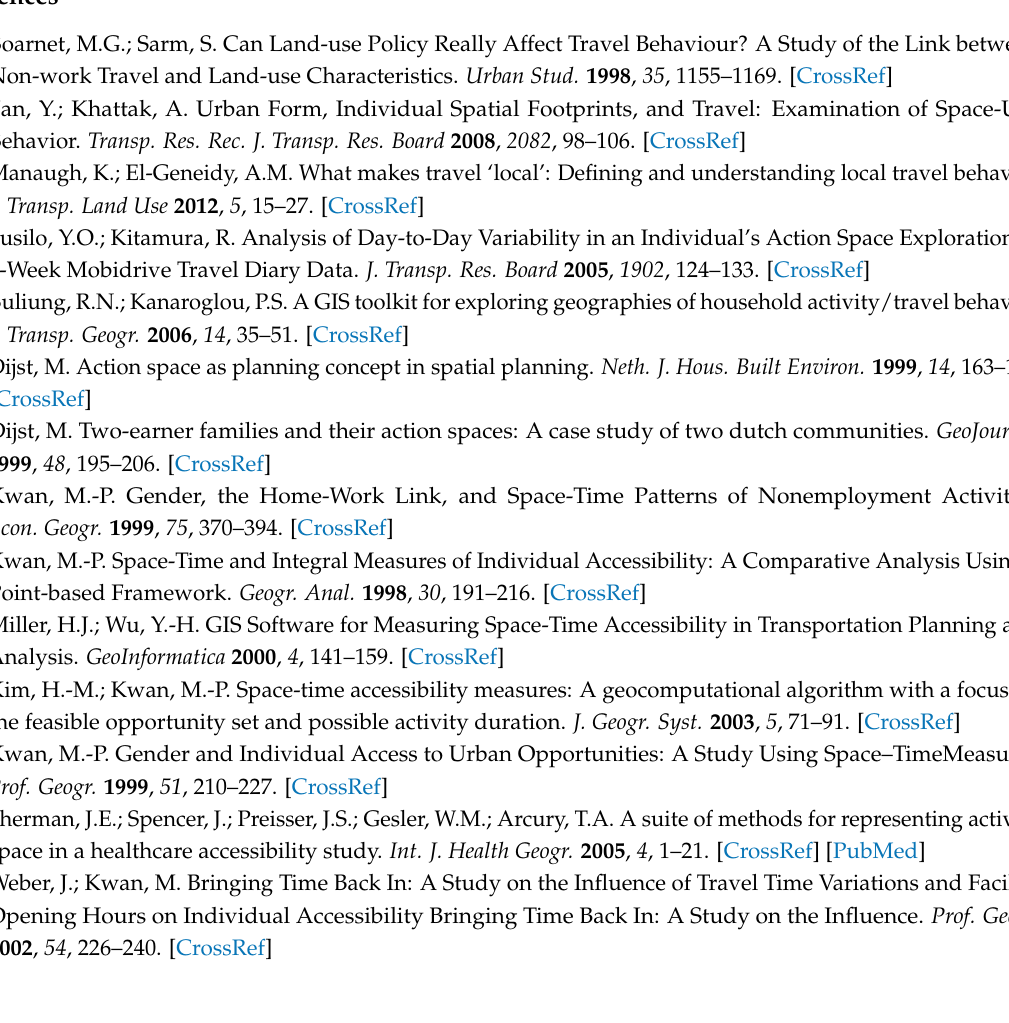
Table S17: Attitudinal Characteristic Importance Ranking for the Respondents (Descriptive Statistics of Likert scale variables related with perception), Table S16: KMO and Bartlett’s Test: Factor analysis (Descriptives), Table S18: Total variance explained for extracted factors, Figure S10: Scree plot indicating that the data have eleven factors, Figure S4: Existing land use distribution, Figure S5(a): Reclassification to five types of land uses for diversity measurement, Figure S5(b): SPN with selected land use within buffer area for diversity measurement, Figure S6: Land use distribution comparison between total area and within the area of all respondent’s activity space. All GIS database can be found at